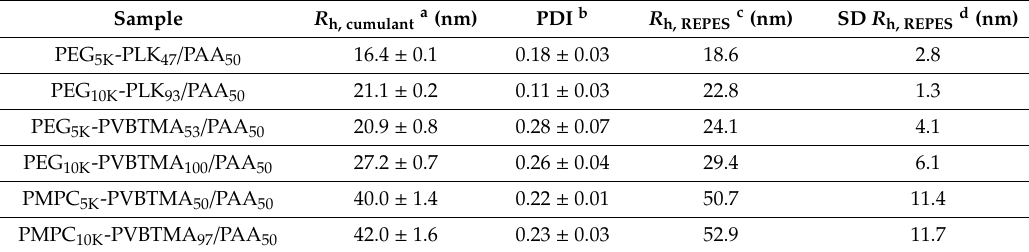
Table 2. Dynamic light scattering (DLS) summary of all prepared polyelectrolyte complex